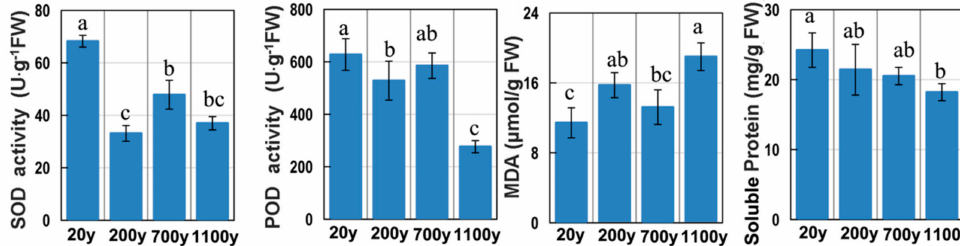
Figure 2. Superoxide dismutase (SOD) and peroxidase (POD) activities as well as the malondialdehyde (MDA) and soluble protein contents. All data points are means ± SD ( n = 3). Means in each column followed by di ff erent lowercase letters are significantly di ff erent ( p < 0.05).